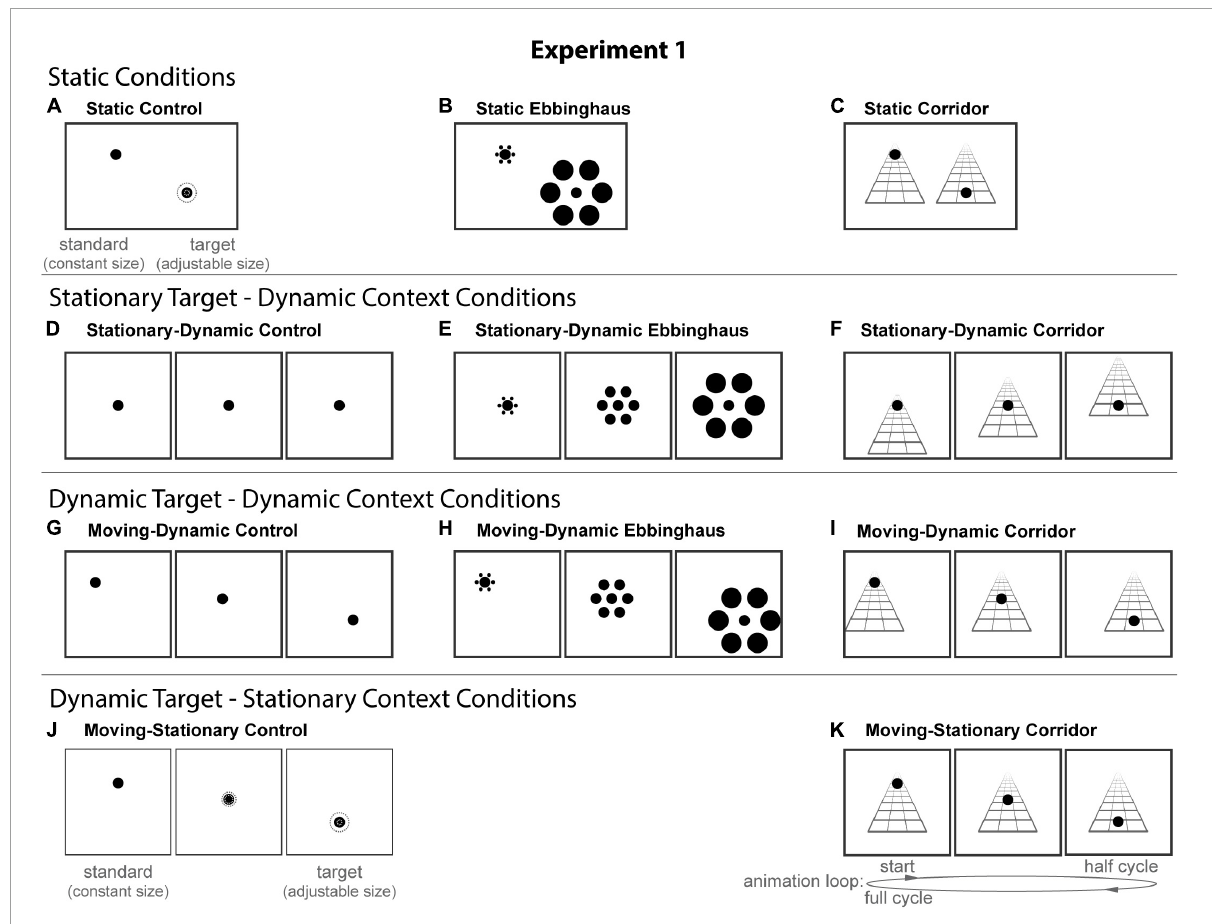
FIGURE2 The 11 conditions of Experiment 1. Columns represent the three distinct contexts [Control (A,D,G,J) , Ebbinghaus (B,E,H) , Corridor (C,F,I,K) ]. Rows represent the four configurations [Static (A–C) , Stationary-Dynamic (D–F) , Moving-Dynamic (G–I) , Moving-Stationary (J,K) ]. We did not include a Moving-Stationary Ebbinghaus as it was not possible to create this an Ebbinghaus variant with target motion, but without context motion. For all Dynamic conditions (D–K) , screenshots for the beginning (standard circle), middle, and end (target circle) frames are shown. The animation [as labeled in panel (K) ] played in a continuous loop. In the figure, the circle is the same physical size in all frames; during the experiment, the target (lower right circle for Static conditions or the far-right frame for Dynamic conditions) was adjusted by the participant [see panels (A,J) ]. Here, stimuli are cropped to display the central portion of the screen to save space; stimulus components (e.g., Ebbinghaus inducers) did not come so close to the edge of the monitor. Supplementary Video 1 showing all of the dynamic conditions for Experiment 1 can be found in the Supplementary materials (best viewed in “loop”